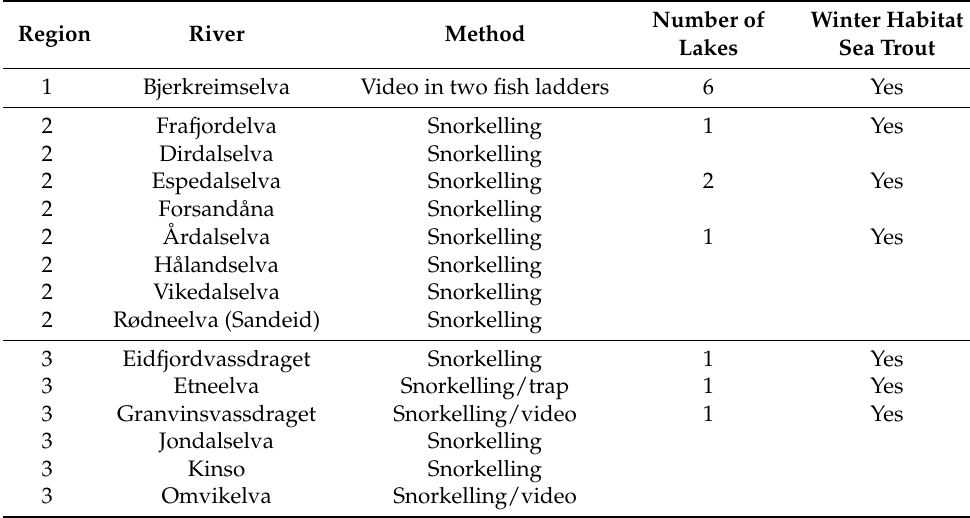
Table 1. The methods used for measuring in-river population size in each of the 27 rivers in the eight